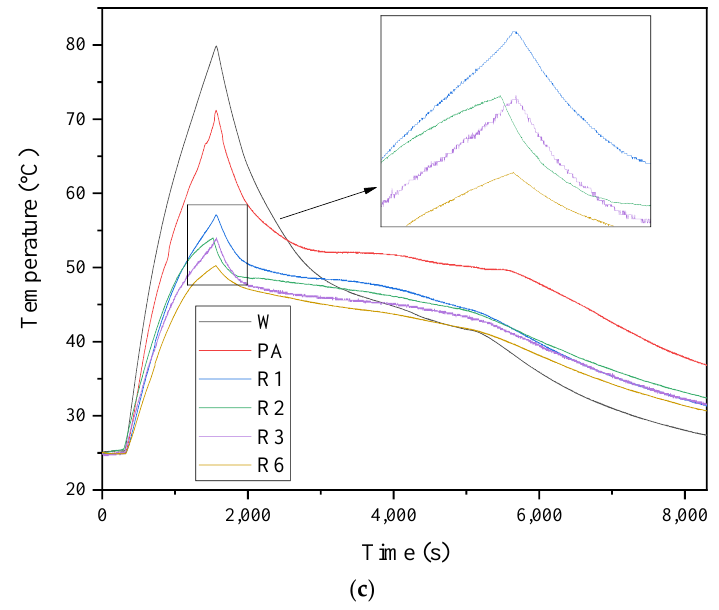
Figure 9. Battery pack temperature curve ( a ) 1 C, ( b ) 2 C, ( c ) 3 C. Figure 10 shows the temperature difference curve of the battery string. For the battery pack, there will be temperature differences between the cells in the battery string. A long running time may result in large performance differences among battery packs. Therefore, the safety and service life of the entire battery string are seriously affected. During battery string operation, the temperature difference between batteries should not exceed 5 ◦ C [36]. Under natural ventilation, the heat dissipation between batteries is slow and the temperature difference is large. At 1 C condition, the temperature difference without using PCM is also within 5 ◦ C, the highest is 3.4 ◦ C. The addition of flame-retardant PCM makes the temperature difference smaller, up to 1.4 ◦ C. 2 C and 3 C do not use PCMs, and the maximum temperature difference is 4.6 ◦ C and 9.6 ◦ C. The addition of PCM reduces the maximum temperature difference of 2 C to 3.12 ◦ C and 3 C to 4.25 ◦ C. The use of flame-retardant PCM can make the internal temperature difference of lithium-ion battery string less than 5 ◦ C, and thus improve its safety.